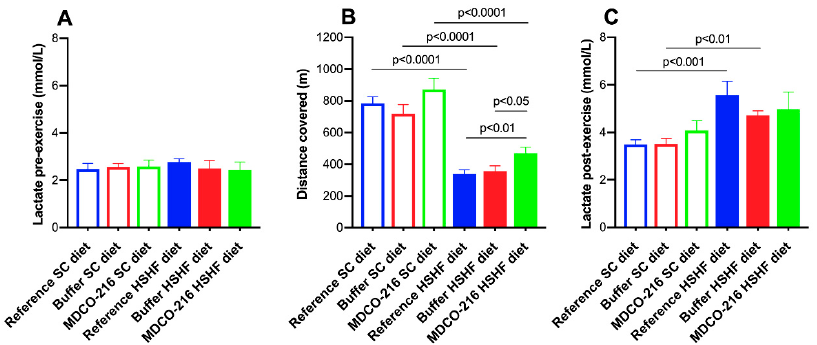
Figure 7. Lactate pre-exercise ( A ), distance covered ( B ), and lactate post-exercise ( C ) in reference, buffer, and MDCO-216 C57BL/6N mice fed the SC diet or the HSHF diet. All data represent means ± SEM ( n = 10).